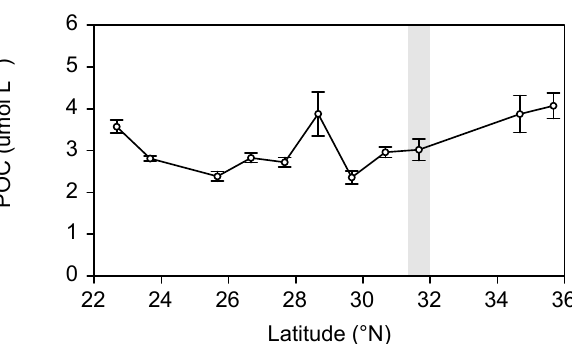
Fig. A2. Particulate organic carbon (POC) as a function of latitude across the BV47 cruise transect (see Fig. 1). Shaded region represents approximate location of BATS. POC varied among stations (P=0.002, Kruskal–Wallis ANOVA – analysis of variance), but was not signifi- cantly correlated with latitude (Spearman rank correlation, ρ =0.46, P=0.082).